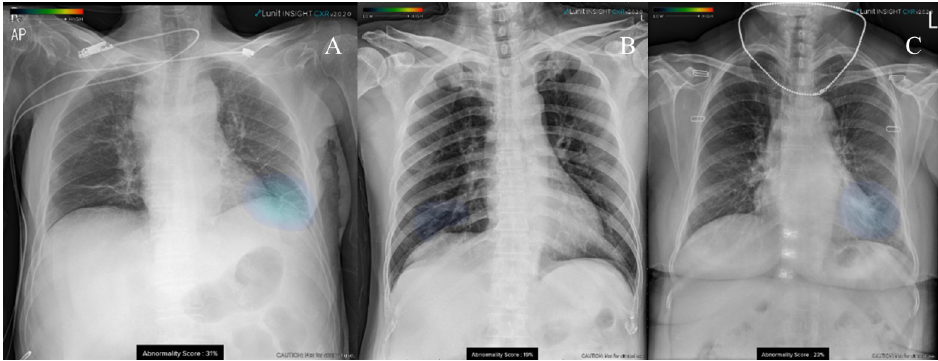
Fig 3. False-positive interpretations of DL algorithm. DL algorithm heatmap overlaid on image feature related to (A) interstitial thickening and (B, C) normal vascular marking.